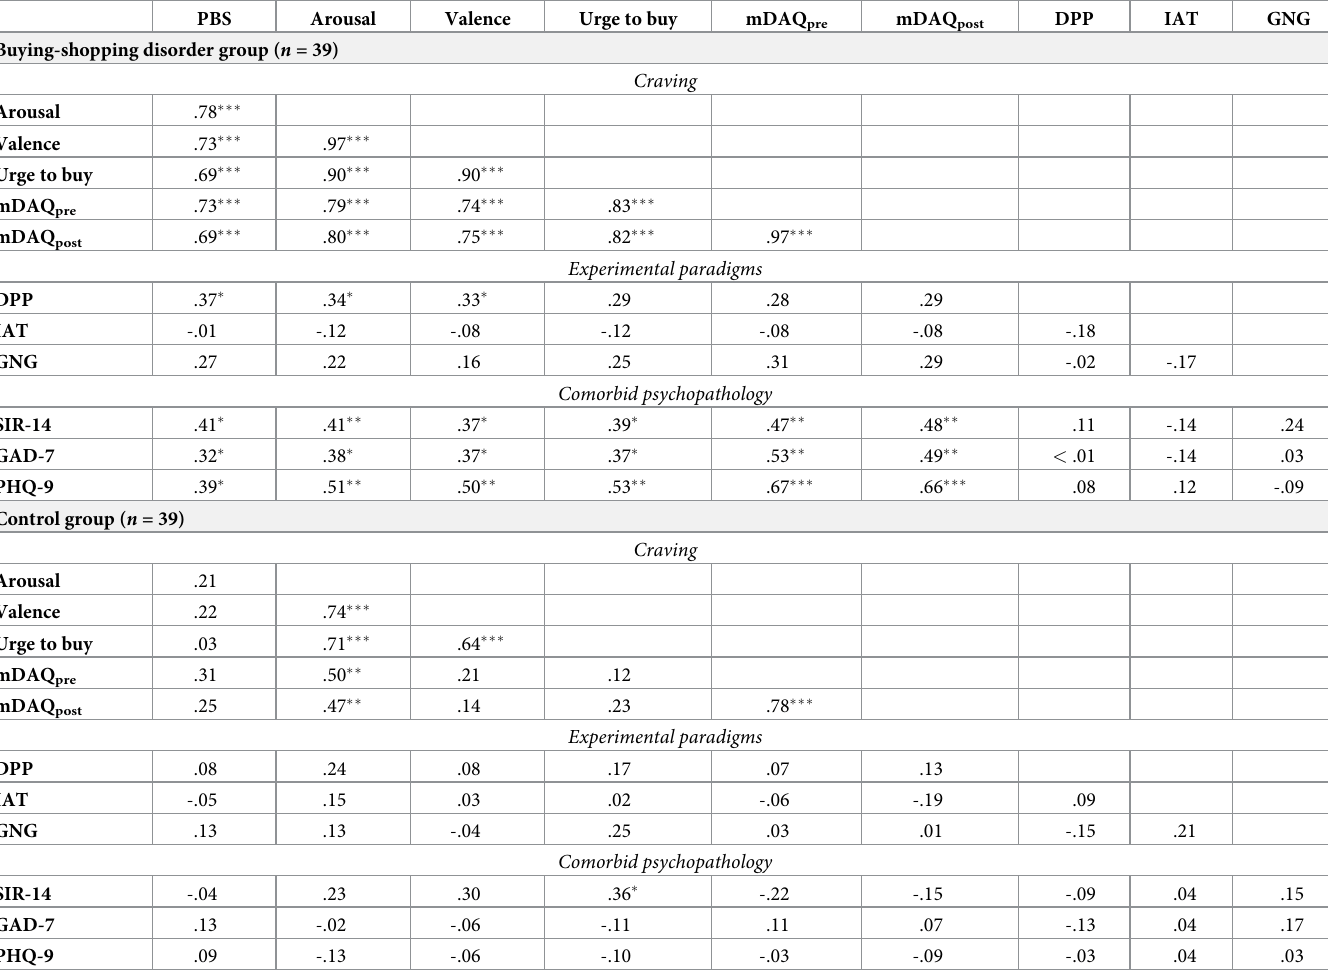
Table 2. Two-tailed Pearson correlations ( r ) of buying-shopping disorder symptoms with craving variables, performance in experimental paradigms, and comorbid psychopathology. PBS Arousal Valence Urge to buy mDAQ pre mDAQ post DPP IAT GNG Buying-shopping disorder group ( n = 39)